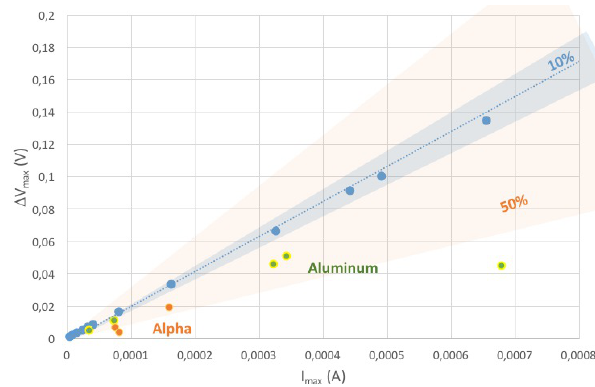
Fig. 17. Calibration curve and detected currents concerning diagonal configurations for the aluminum ion or the alpha particle crossing in a fifteen contacts matrix.